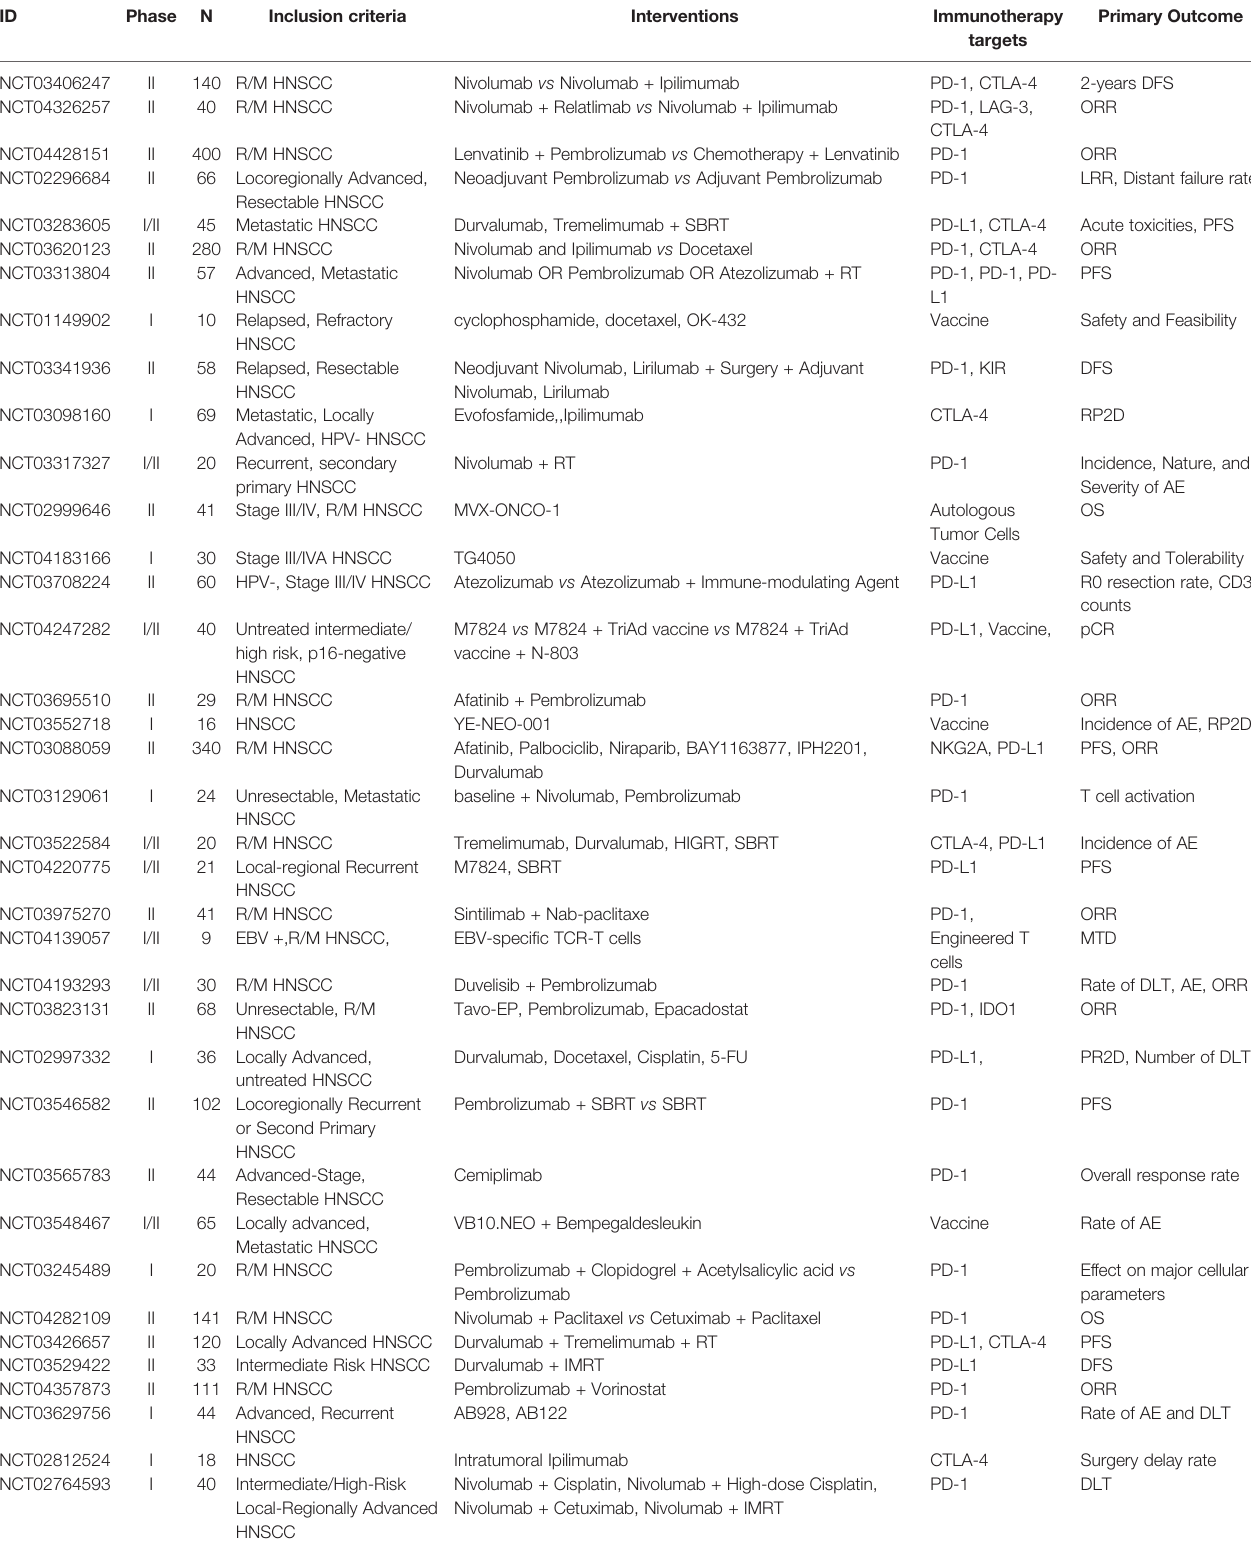
TABLE 1 | Summary of ongoing clinical trials in